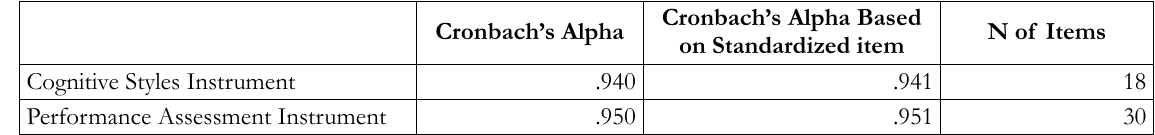
Table 4. Reliability Test of cognitive styles and Performance Assessment Instrument